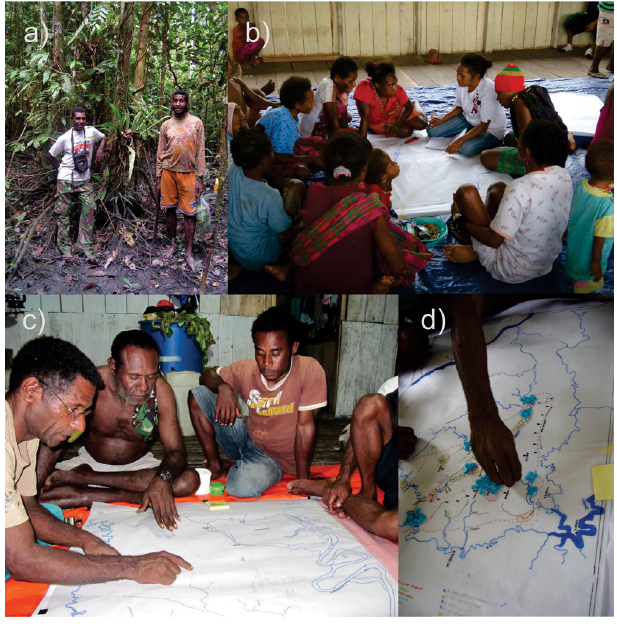
Fig. 4 . Methods used to engage community members regarding the examples in this study. (a) Field visits with informants (Kay, DS); (b) focus group discussion around the results of the initial participatory mapping with a group of women (Metaweja, GB); (c) discussing locations on participatory map with men (Yoke, MB); (d) hunters scoring the frequency of visits to the community boundary (Metaweja,